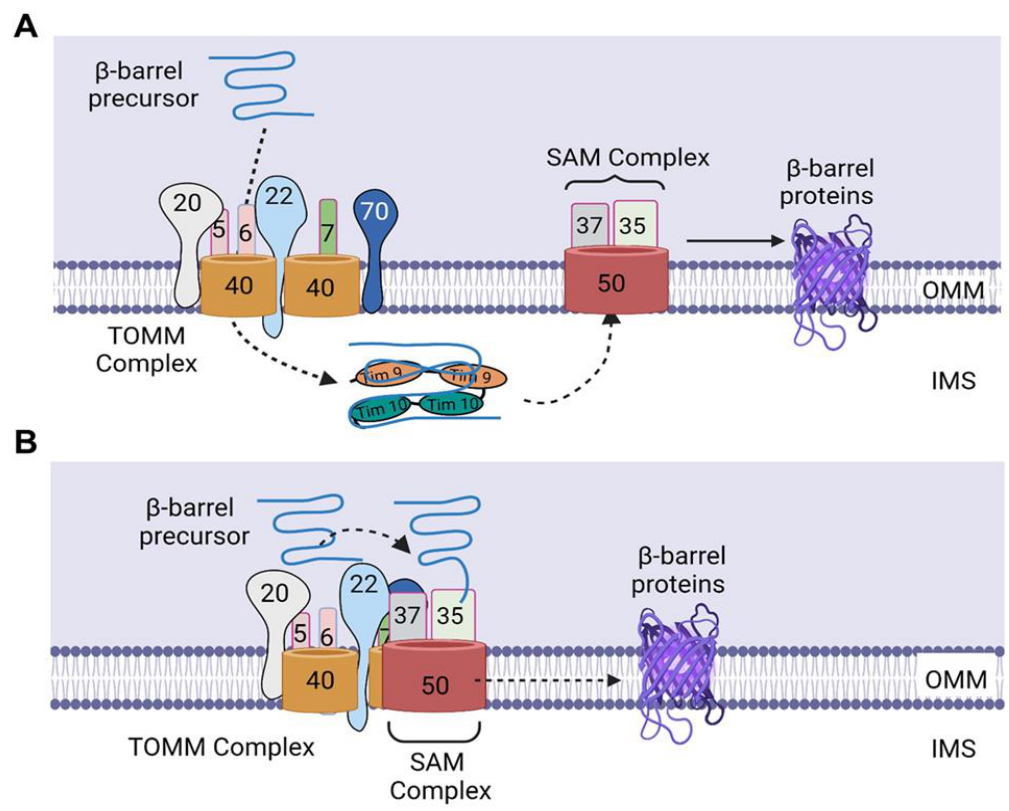
Figure 2. Import of β -barrel precursors into the outer mitochondrial membrane. ( A ) Upon translocation through the TOMM40 channel, the precursors bind to TIMM9 – TIMM10 complex, which protect the β -barrel precursors from aggregation in the aqueous IMS and deliver the β -barrel precursors to the SAM complex. Subsequently, the precursors are folded in the SAM complex and laterally released into the lipid phase of the outer membrane. ( B ) SAM37 interacts with the cytosolic receptor domain of TOMM22, thereby linking the two complexes and leading to the formation of a TOMM–SAM supercomplex, which enables the binding of SAM35 to the β signal of the precursor, thereby allowing the direct transfer of the β -barrel precursors from TOMM to the SAM complex. Subsequently, the β -barrel precursors are inserted into the SAM50 channel, after which they are folded in the SAM complex and released laterally into the lipid phase of the outer membrane. IMS, intermembrane space. The figure was created with Biorender.com.